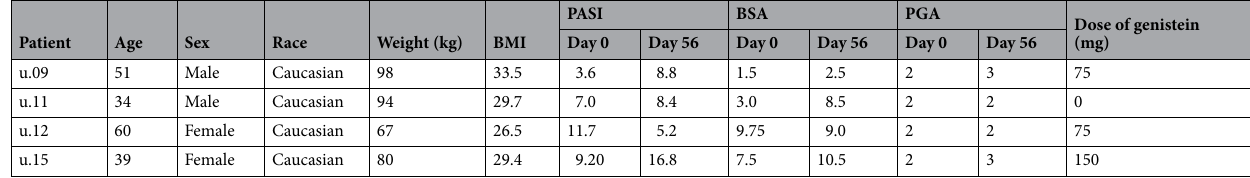
tively, in the placebo group. The obtained pharmacodynamics results were not statistically significant between